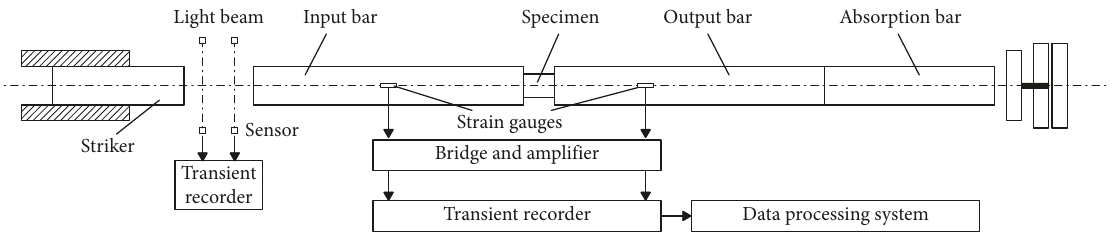
Figure 9: Schematic representation of an SHPB setup